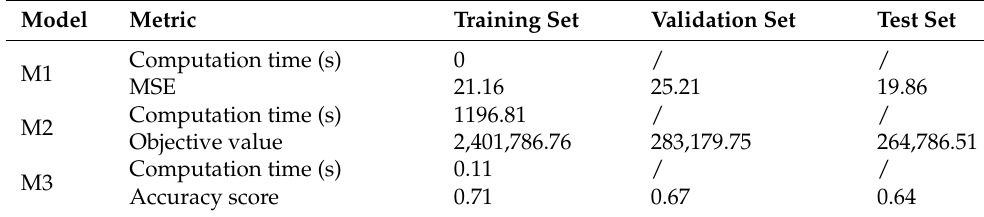
Table 6. Prediction performances of M1, M2, and